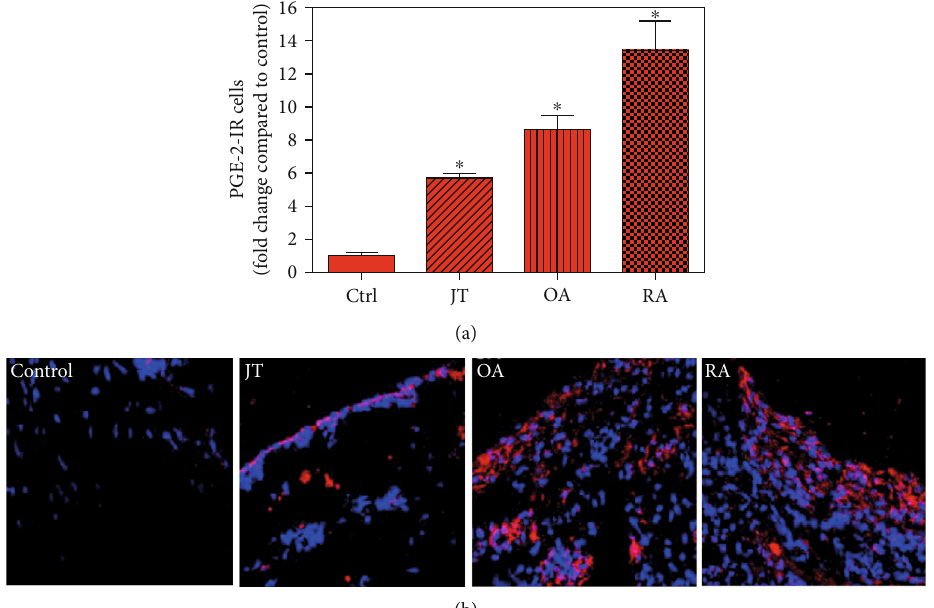
Figure 1: Detection of prostaglandin-E2 (PGE2) in patients with joint trauma (JT), osteoarthritis (OA), and rheumatoid arthritis (RA). (a) Quantitative analysis of immuno fl uorescence microscopy for synovial PGE2-IR cells relative to the synovium of controls (data are shown as means ± SEM ; P < 0 : 05 , Kruskal – Wallis ANOVA on ranks followed by Dunn ’ s test). (b) Immuno fl uorescence microscopy shows that the number of PGE2-IR cells (Texas red fl uorescence) is increased in various forms of in fl ammatory joint disease compared to controls which was most prominent in rheumatoid arthritis. DAPI blue fl uorescence shows nuclear staining. Bar = 20 μ m . ( ∗ P < 0 : 05 , compared to control).